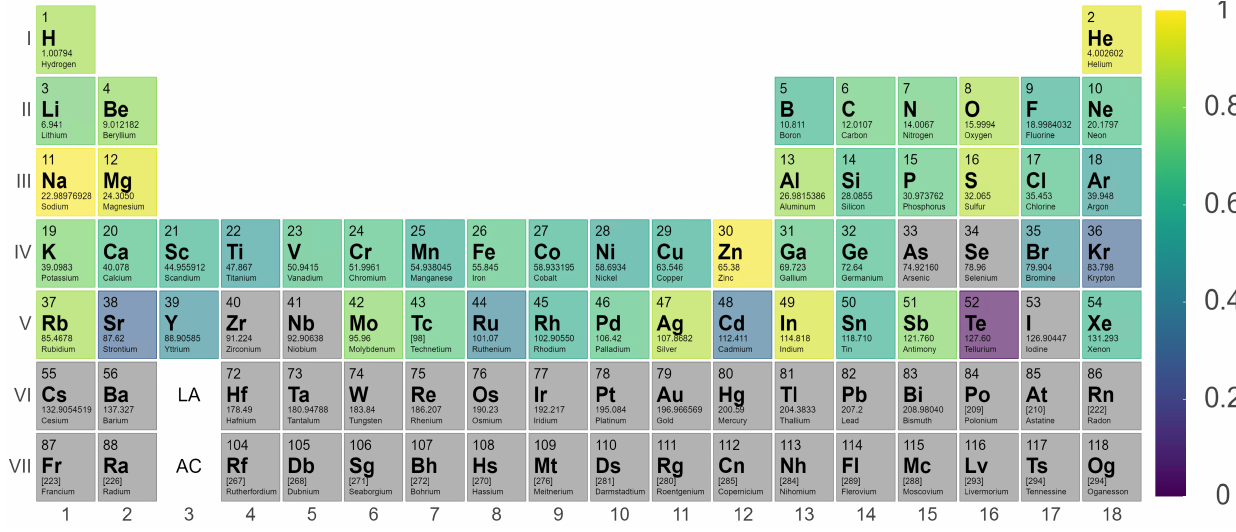
Figure 2. applied to modeled elements across the first five periods of the periodic W 3X